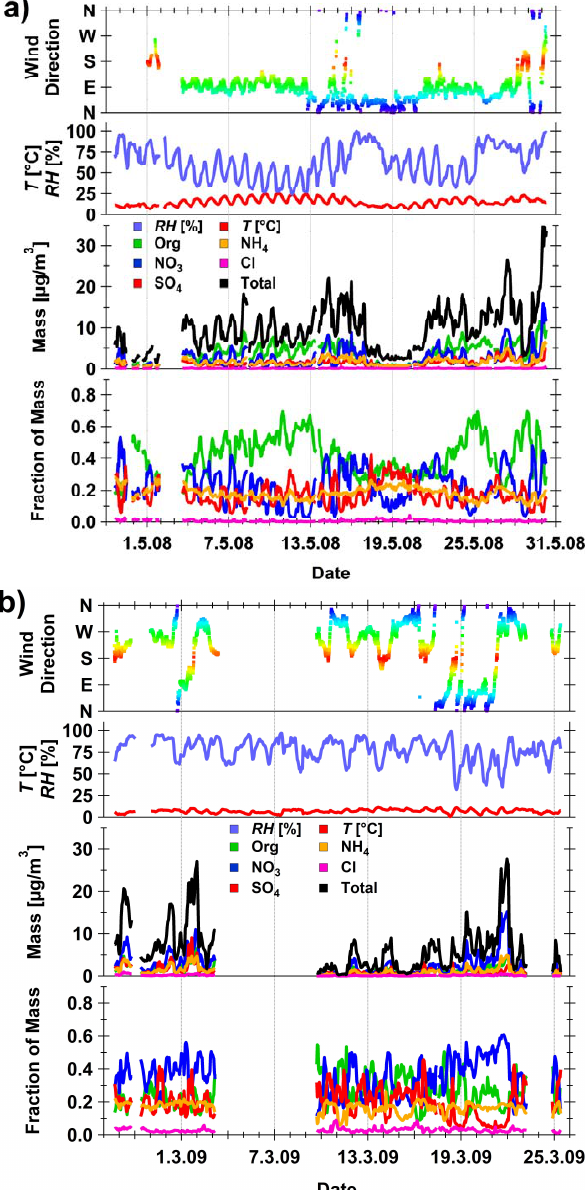
Fig. 1. Campaign overviews of aerosol chemical composition in May 2008 (a) and March 2009 (b) . Mass concentrations (second lowest panel) and relative contributions (lowest panel) are shown for total AMS measured mass (black), ammonium (orange), nitrate (blue), sulfate (red), organics (green), and chloride (purple). The ambient temperature and RH in the second upper panel as well as the wind direction in the most upper panel are given in both graphs. As a guidance of the eye, northerly wind directions are colored in blue, southerlies in red, and easterly and westerly wind directions in